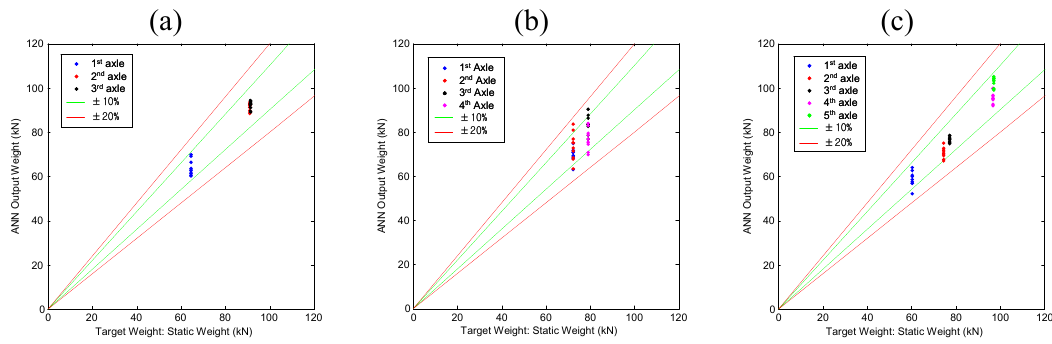
Figure 12. Performances of trained ANN (a) 3-axle test truck. (b) 4-axle test truck. (c) 5-axle test